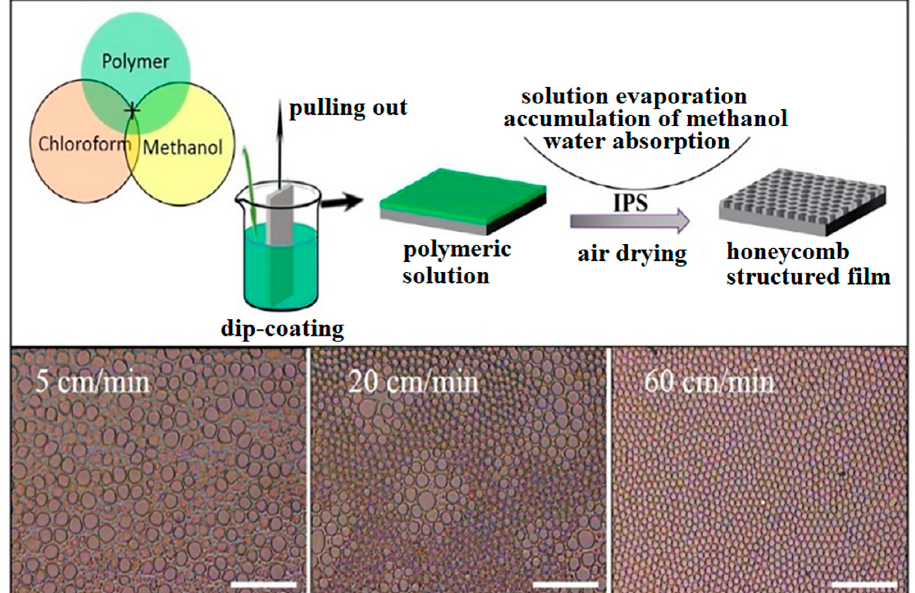
Figure 7. The effect that the speed of the substrate’s withdrawal from the solution using the dip- coating technique has on the morphology of the HCP layers [52].